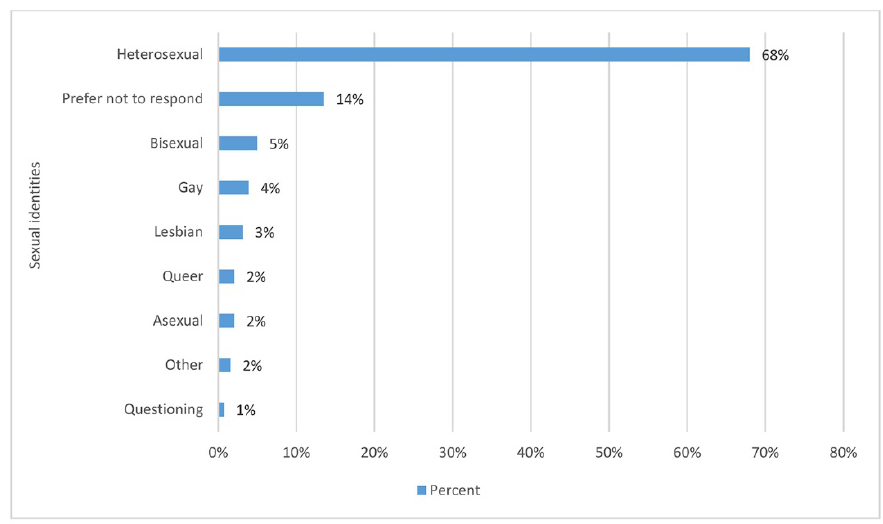
Figure 4 Sexual identity by